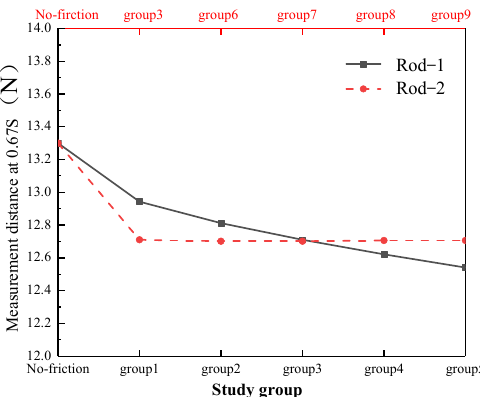
Figure 17. x-directional collision force between locking jaw and locking rod.